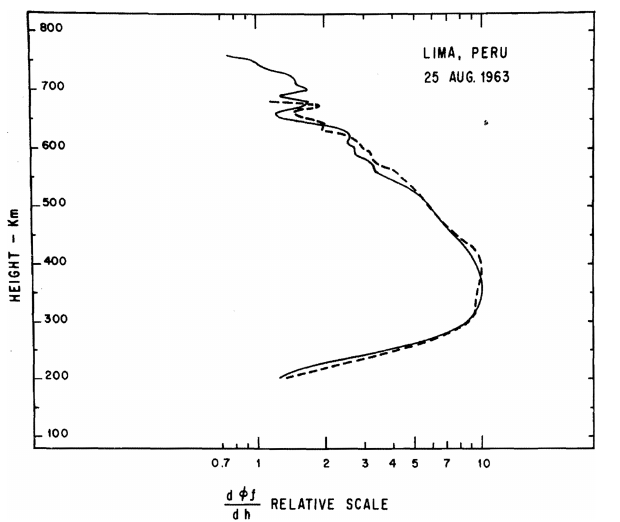
Figure 18. Two examples of the first Faraday profiles measured with the Jicamarca incoherent scatter radar and processed using the PB250 computer. The curves have been derived from data “smoothed” by the computer (reproduced from Bowles,